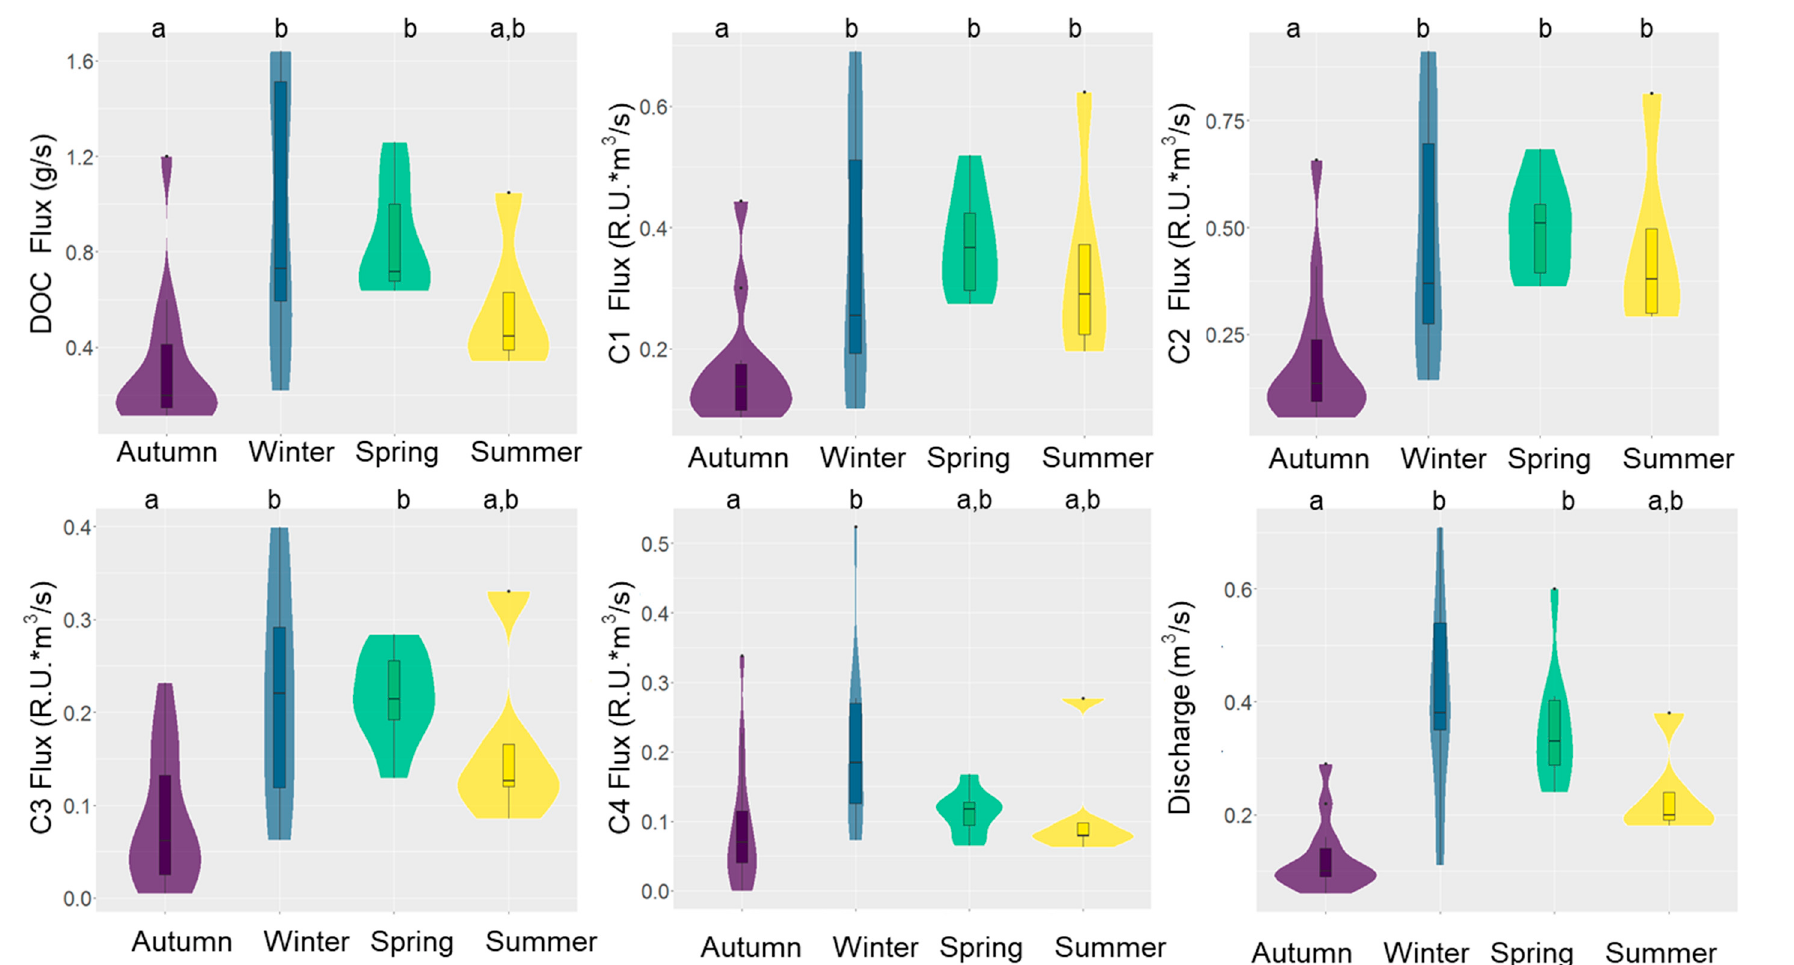
Figure 6. Violin and box plot comparison of DOC/DOM fluxes and discharge across seasons in the Mayfield Creek, southeastern United States. Boxes show the interquartile ranges (25th and 75th percentile), black lines across the boxes denote the median, and whiskers extend to 1.5 times the interquartile range. Black dots refer to outliers (i.e., beyond 1.5 times the interquartile range above the upper quartile and below the lower quartile). The width of color-shaded areas is proportional to the frequency of the corresponding Y values. Different letters above the boxes indicate significant differences detected by the non-parametric Kruskal–Wallis test with Dunn post hoc test.